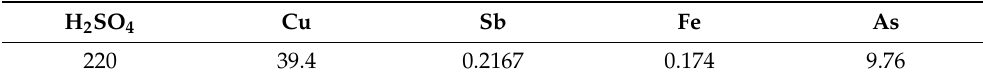
Initial concentration (in g/L) of the Chilean contaminated electrolyte treated by Cifuentes et al. [96] using ion-exchange resins.